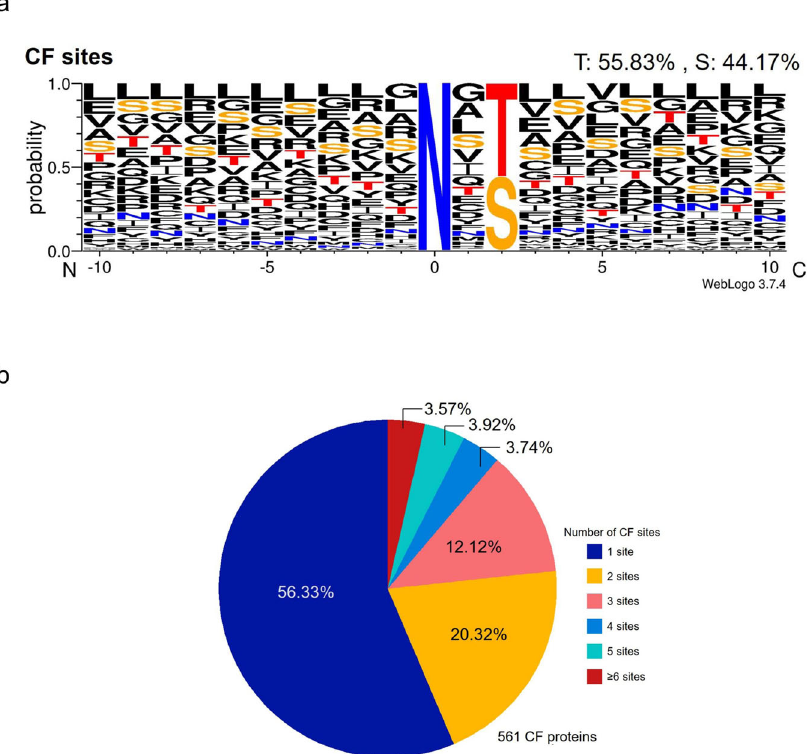
Fig. 4 Analysis of consensus motifs for CF glycosites identi fi ed and distribution of CF glycosites on CF site-contained glycoproteins by the STAGE method. a Relative frequency of ±10 amino-acid residues around the asparagine of N-linked glycosylation site ( fi xed at the center position of 0) was obtained by using fl anking sequences derived from all CF sites consisting of Pep + HexNAc-Fuc identi fi ed using the STAGE method. Threonine (T, red) is the most frequently observed amino acid residue in position 2 for CF sites. N = Asparagine (blue), S = Serine (yellow), and the rest of the amino acid residues are in black. b Distribution of CF site-contained glycoproteins (CF proteins # ) with ≥ 1 CF sites that were identi fi ed by the STAGE method. # CF proteins: glycoproteins had at least one CF site identi fi